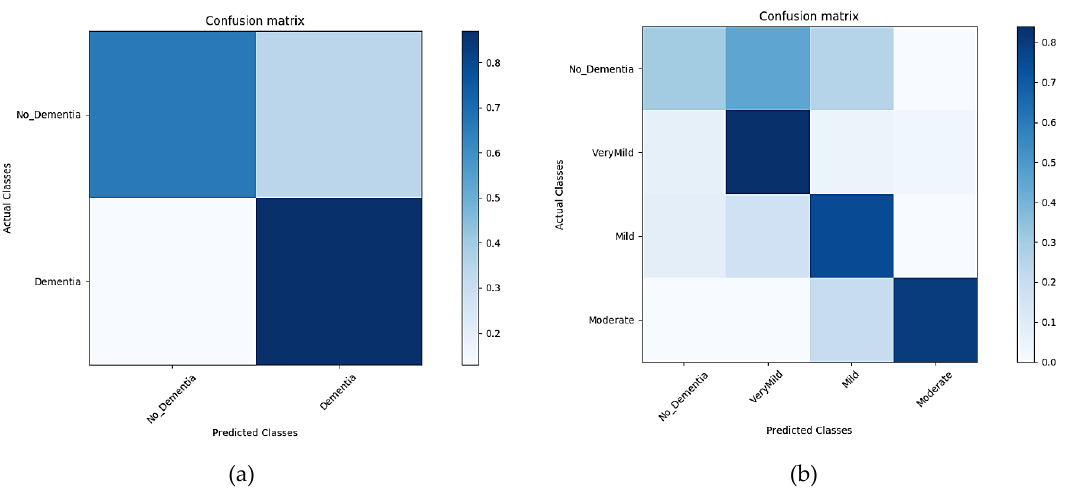
Figure 9. Confusion matrix of the Segment 3 dataset ( a ), representing the confusion matrix of the binary dataset. ( b ) A confusion matrix of multiple classes.